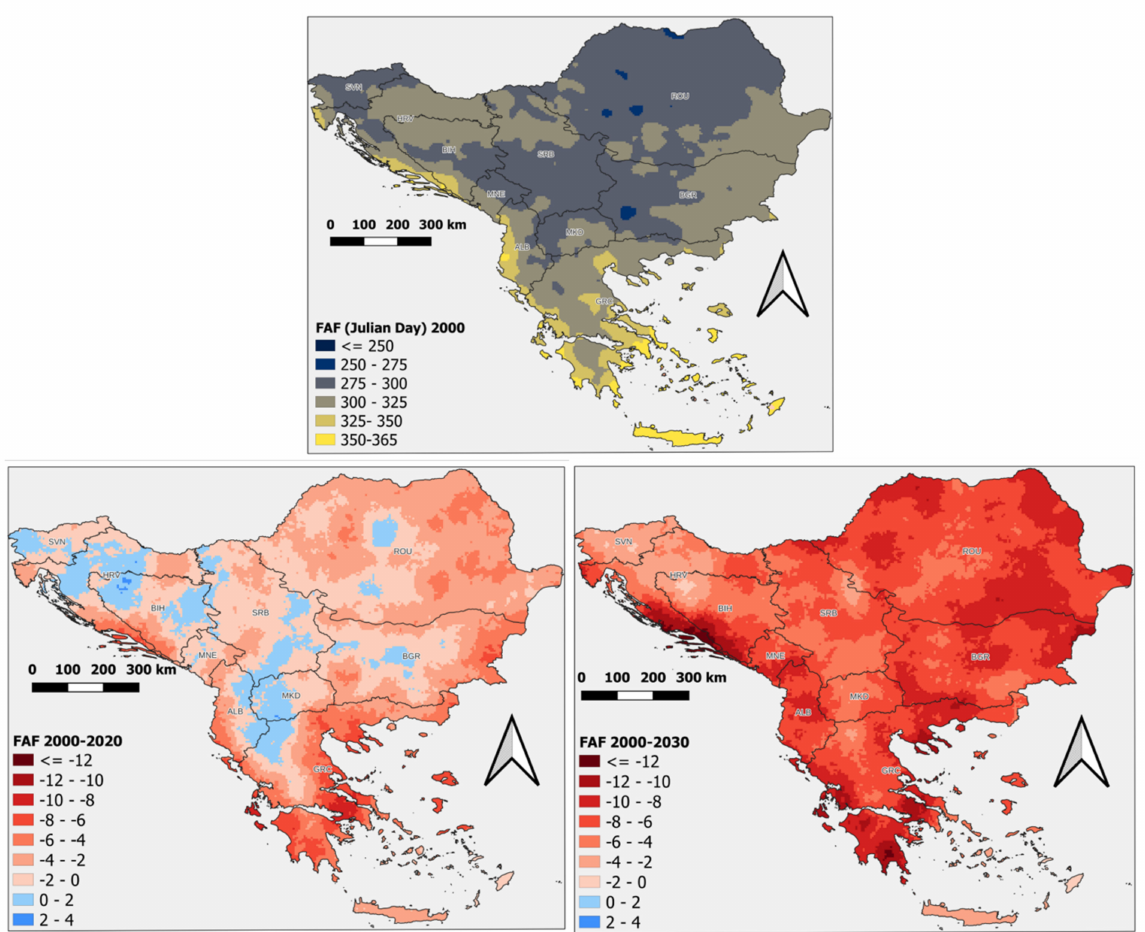
Figure 8. First Autumn Frost (FAF) in Julian days. Reference period ( upper image), the difference between the reference period and the 2020 horizon ( down left ) and the difference between the reference period and the 2030 horizon ( down right